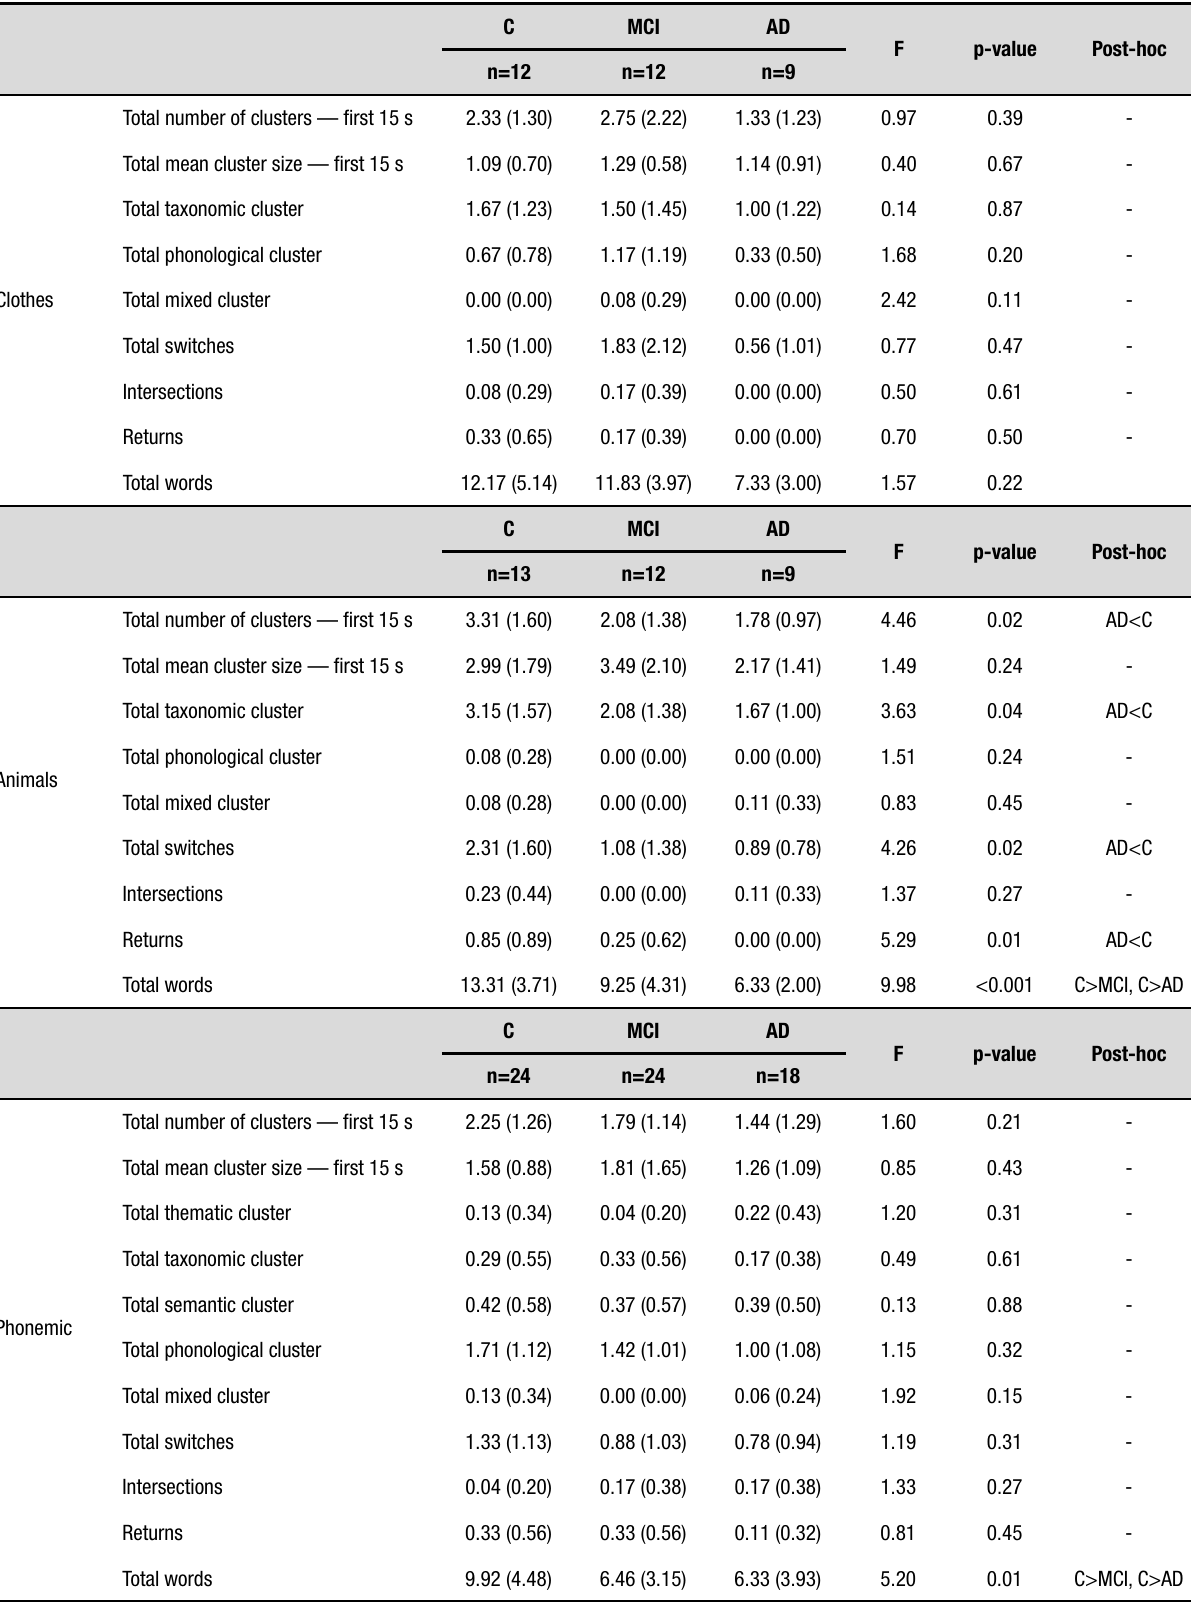
Table 2. Participant’s verbal fluency